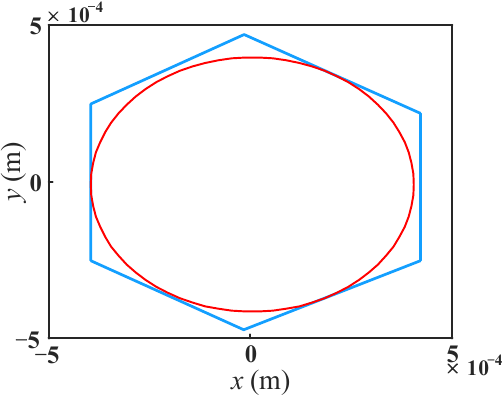
Figure 15. Comparison of the workspace between original and optimized mechanism, ( a ) the maximum cross-section of the workspace of the mechanism; ( b ) micromanipulator workspace. Figure 14. Maximum cross-section of the workspace of optimized mechanism. Figure 14. Maximum cross-section of the workspace of optimized mechanism. Figure 14. Maximum cross-section of the workspace of optimized mechanism.